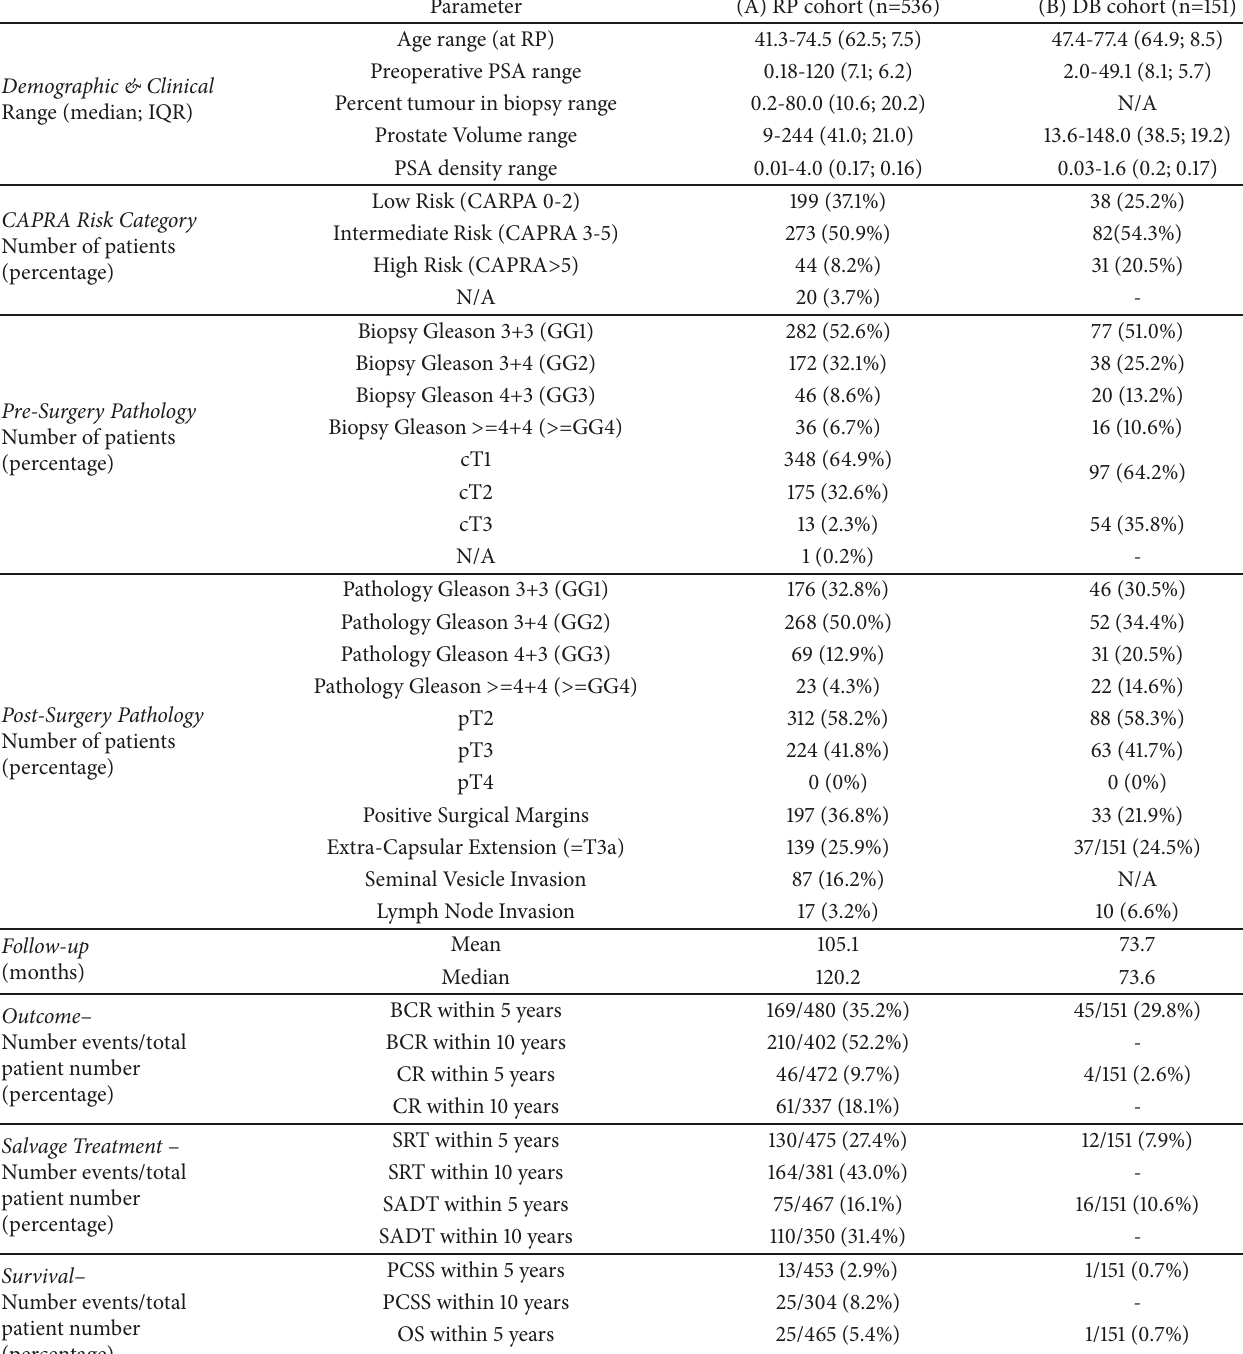
Table 1: Aggregated summary of the characteristics of the studied patient cohorts. (A) Demographics of the radical prostatectomy (RP) patient cohort including the 536 patients eligible for statistical data analysis. For patient age, preoperative PSA, percentage of tumour in biopsy, prostate volume, and PSA density the min and max values in the cohort are shown; median and IQR (interquartile range) are shown in parentheses. Pre- and postsurgical pathology is given ( Note. extracapsular extension was derived from pathology stage information). The outcome category illustrates the cumulative 5- and 10-year biochemical recurrence (BCR) and clinical recurrence to metastases (CR) postsurgical primary treatment. The treatment category lists the cumulative 5- and 10-year start to SRT (salvage radiation therapy) or SADT (salvage androgen deprivation therapy) after surgery. Mortality is shown as prostate cancer specific survival (PCSS) as well as overall survival (OS) (N/A=notavailable). (B)Demographics of the diagnostic biopsy (DB) patientcohort.In total diagnostic needle biopsy tissues of 151 were eligible for statistical data analysis. The demographics and clinical data of this cohort are presented equivalent to the RP cohort (N/A=not